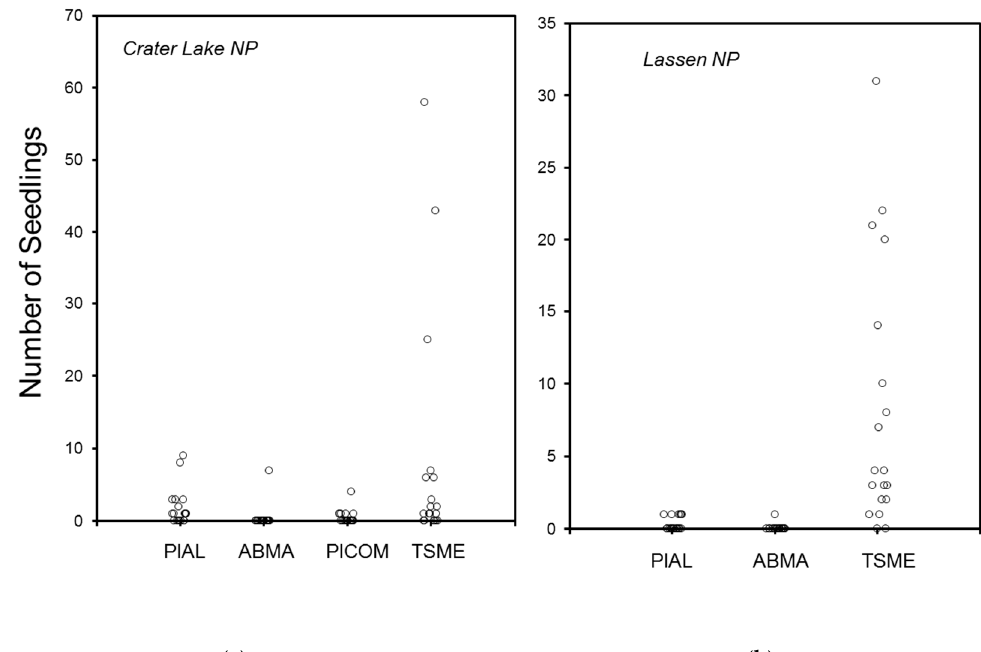
Figure 5. Number of seedlings in 30 whitebark pine plots in ( a ) Crater Lake and ( b ) Lassen Volcanic National Parks. Points are jittered to allow easier viewing. PIAL = Pinus albicaulis , ABMA = Abies magnifica , PICOM = Pinus contorta var. murrayana , TSME = Tsuga mertensiana .